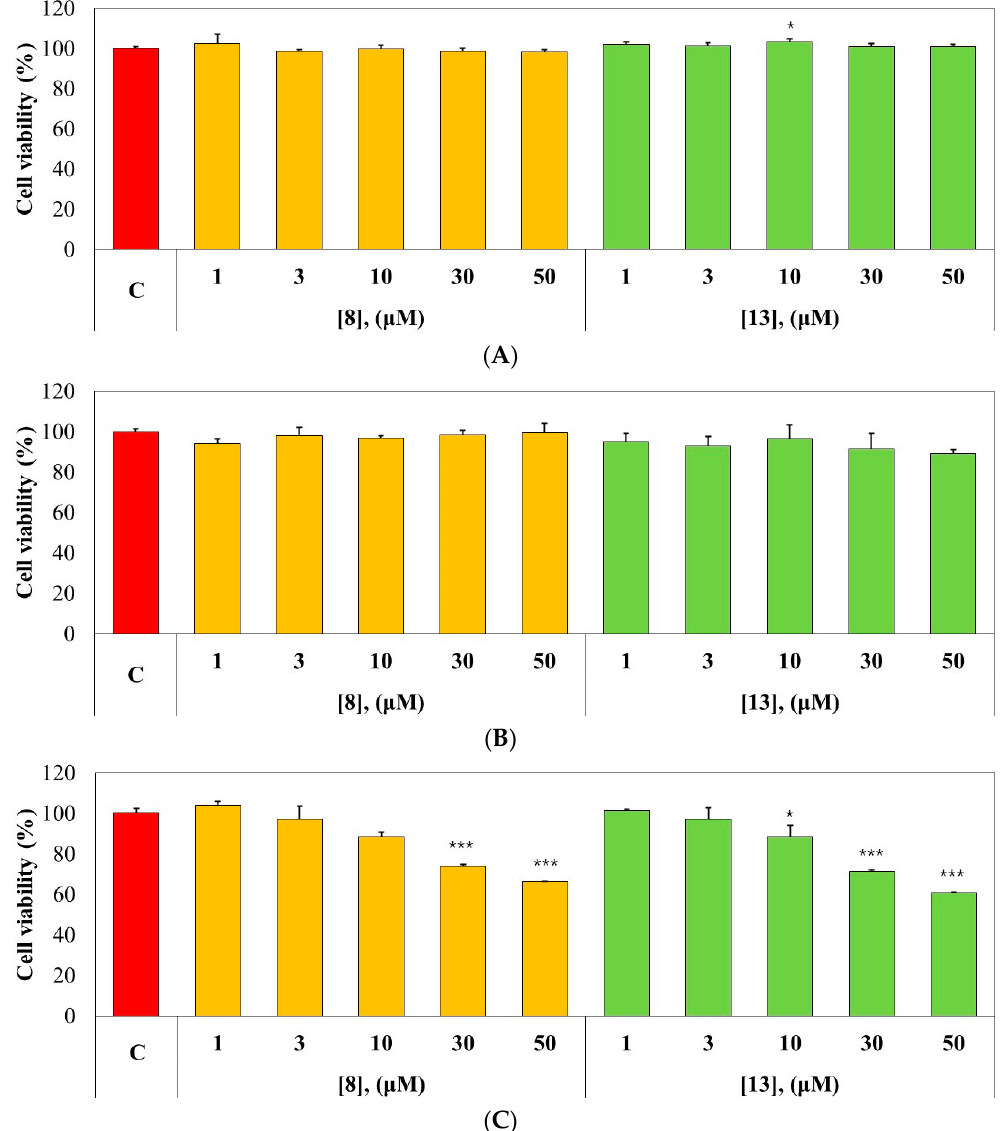
Figure 7. Effects of 8 and 13 on the viabilities of MDCK ( A ), HL-60 ( B ), and SH-SY5Y ( C ) cells. All cell lines were treated with the compounds (at 1, 3, 10, 30, or 50 µM) for 24 h. Culture supernatants were removed and CCK-8 was added for assay. Data are expressed as the means ± SDs of triplicate experiment. * p < 0.05, *** p < 0.001 compared to the control of each cell. C, control.